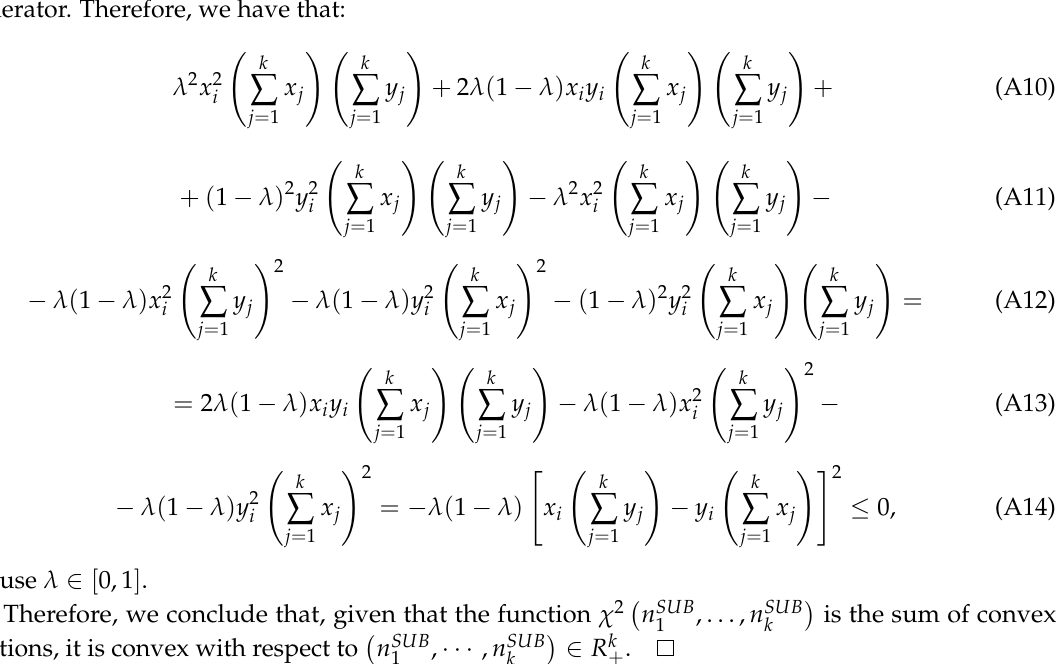
) . Looking , n SUB 2 1